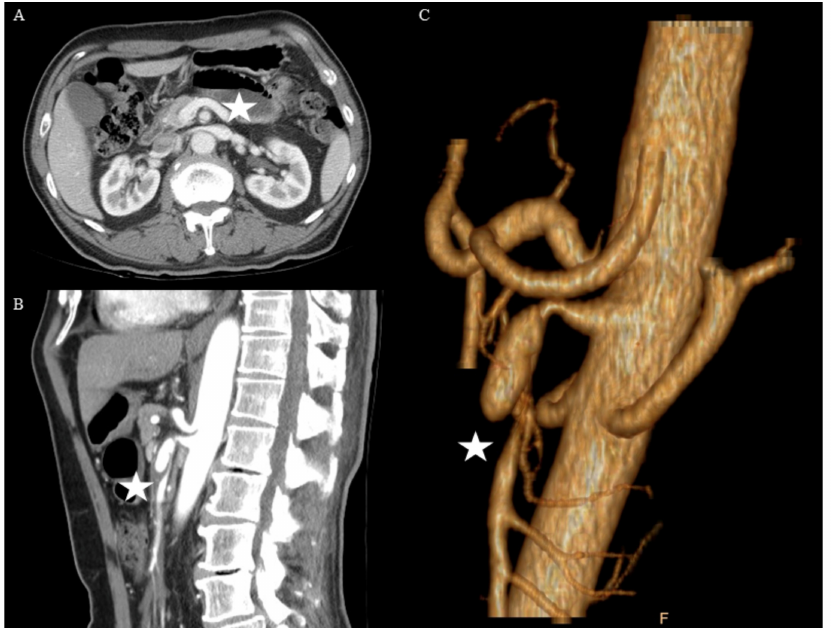
Figure 1. This was a 66-year-old man with Yun’s IIa spontaneous isolated dissection of the superior mesenteric artery (asterisks). Computed tomography (CT) scans, ( A ) axial, ( B ) sagittal, and ( C ) three- dimensional, demonstrated small patent true lumen, and conservative treatment was applied